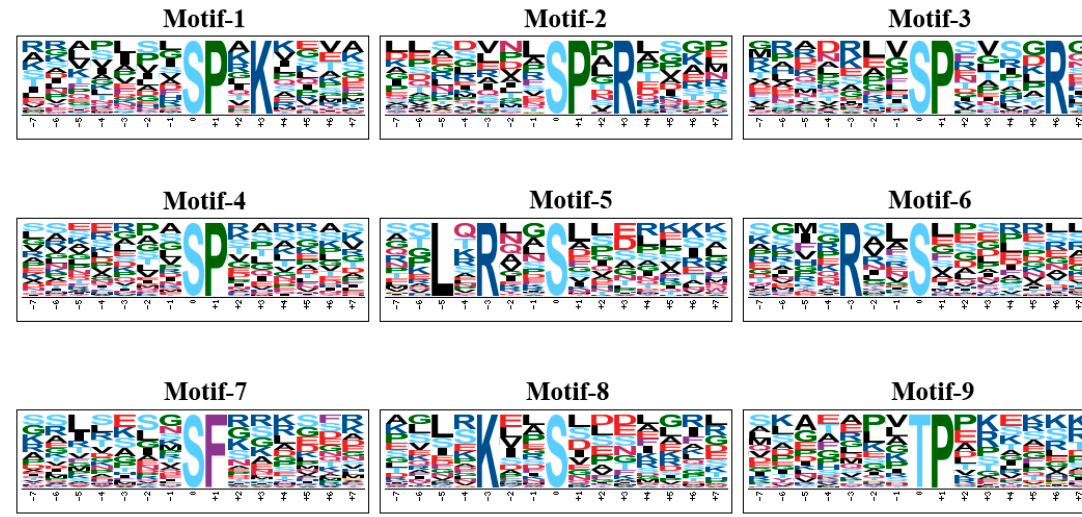
Figure 6. Phosphorylation motifs extracted from the phosphopeptides with the significantly changes by Motif-X from J. curcas seedling under different treatment.